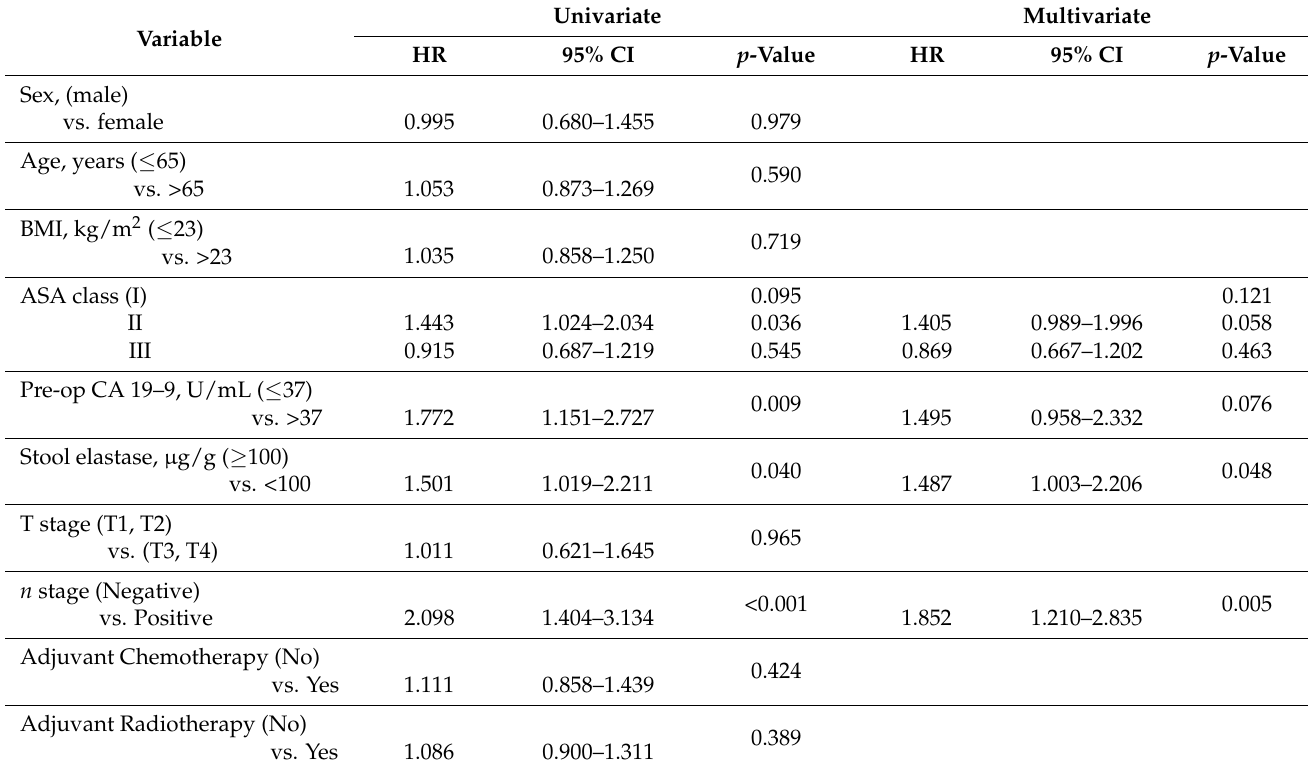
Table 2. Univariate and multivariate analysis of risk factors for overall